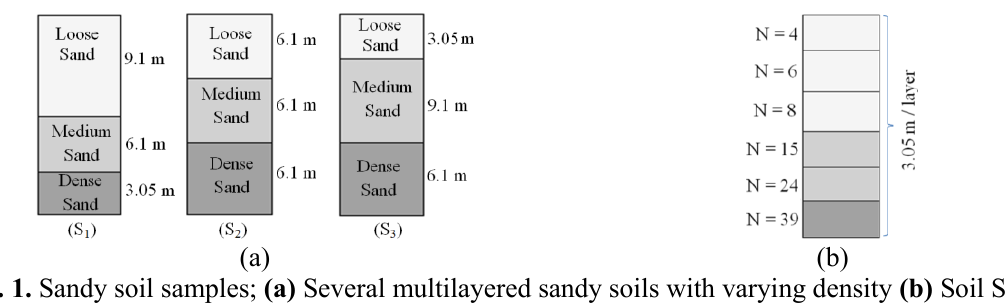
for SPT-N value.